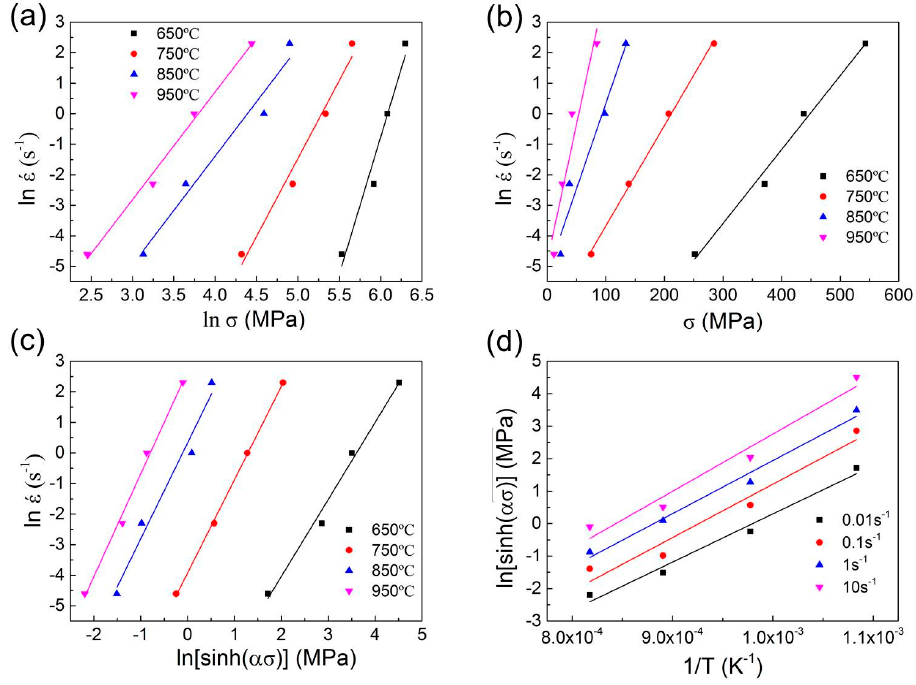
. ε . ; ( d ) ln [ sinh ( ασ )] vs. 1 . (cid:2904) T